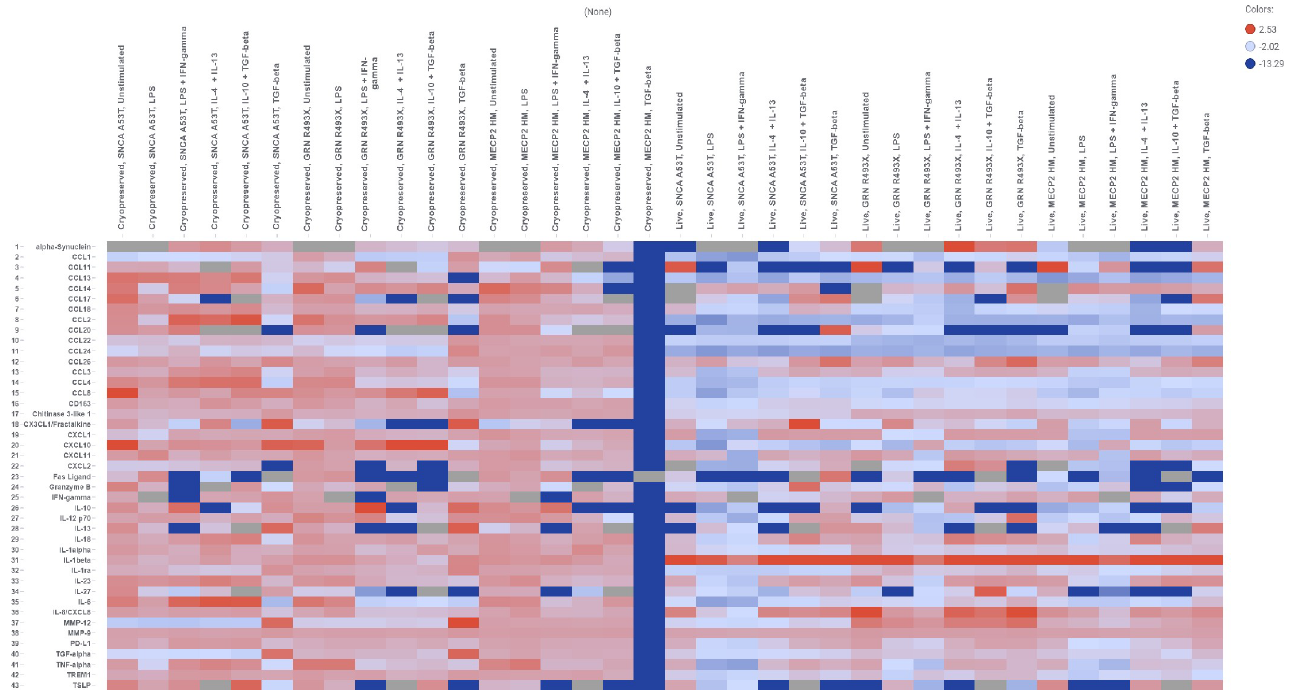
Fig 7. Polarization studies with iPSC derived macrophages from isogenic iPSC for disease